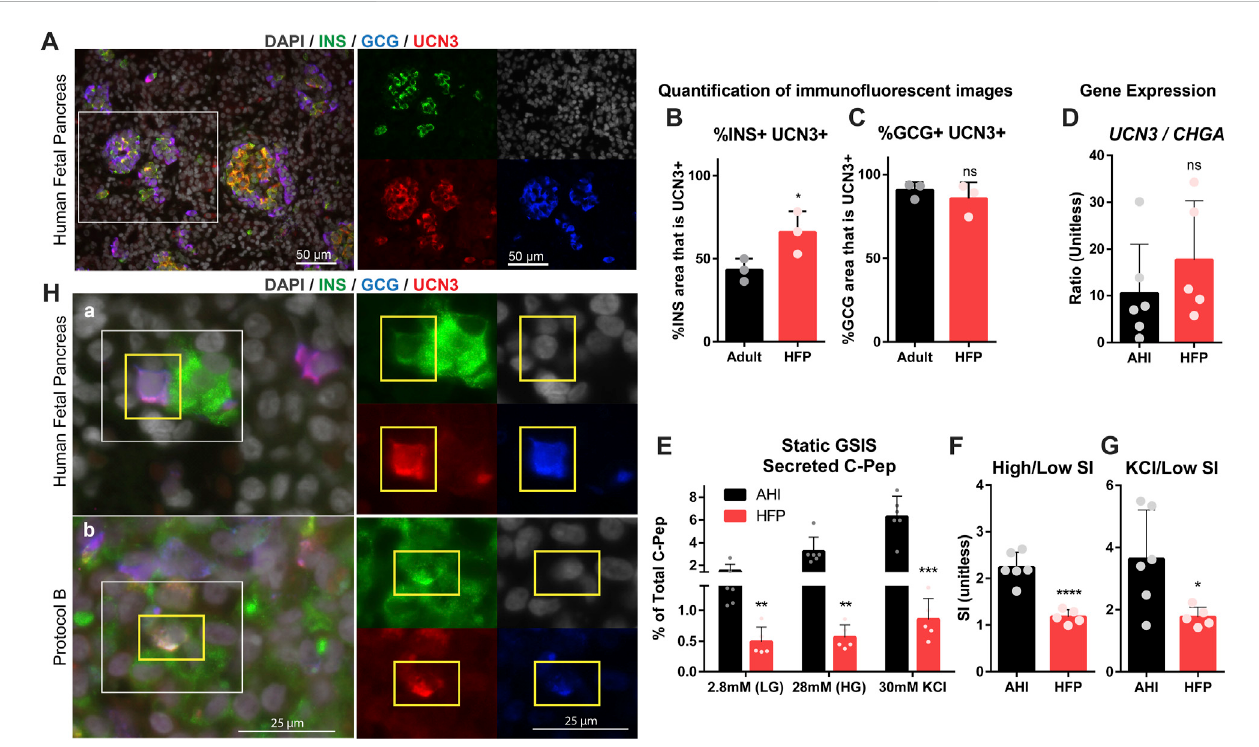
UCN3 is highly expressed in human fetal islets, long before attainment of functional maturation. (A) Immunostaining for insulin (green), glucagon (blue) and UCN3 (red) in human fetal pancreas (HFP). Scale bars are 50 microns. (B) Quanti fi cation of co-localization of UCN3 with insulin in adult human pancreas andHFP. (C) Quanti fi cationofco-localizationofUCN3withglucagoninadulthumanpancreasandHFP. (D) Geneexpressionof UCN3 normalizedto CHGA in adulthumanislets (AHI) and HFP. (E) StaticGSIS assay to assessinsulin secretion inresponse to low glucose (LG, 2.8 mM),highglucose(HG,28 mM)and KCl (30 mM) measured by the concentration of human C-Pep in the supernatant as a percentage of total C-Pep content. (F) Glucose-mediated stimulation index (SI) (C-pep secreted under high glucose/C-pep secreted under low glucose) calculated from the static GSIS assay. (G) Potassium-mediated SI (C-pep secreted under KCl/C-pep secreted under low glucose) calculated from the static GSIS assay. To normalize the number of islets loaded into each GSIS replicateandbecausetheexactfetalisletIEQcouldnotbecounted,GSISresultsarepresentedasapercentageofthetotalinsulincontentofeachsample. (H) (A) InnormalHFP,polyhormonal (INS + GCG + )cellsareconsideredanimmaturepopulationandcanbefoundtoexpressUCN3atthisdevelopmentalstage. (B) In SC-islets derived with Protocol B, UCN3 + INS + GCG + triple-positive cells can also be found. Images of individual channels are the same magni fi cation as the mergedimages.Scale barsare25microns. Statisticalindicatorsdirectly above eachbarare compared toadultpancreasorAHI (ns=not signi fi cant, * p < 0.05, ** p < 0.01, **** p <